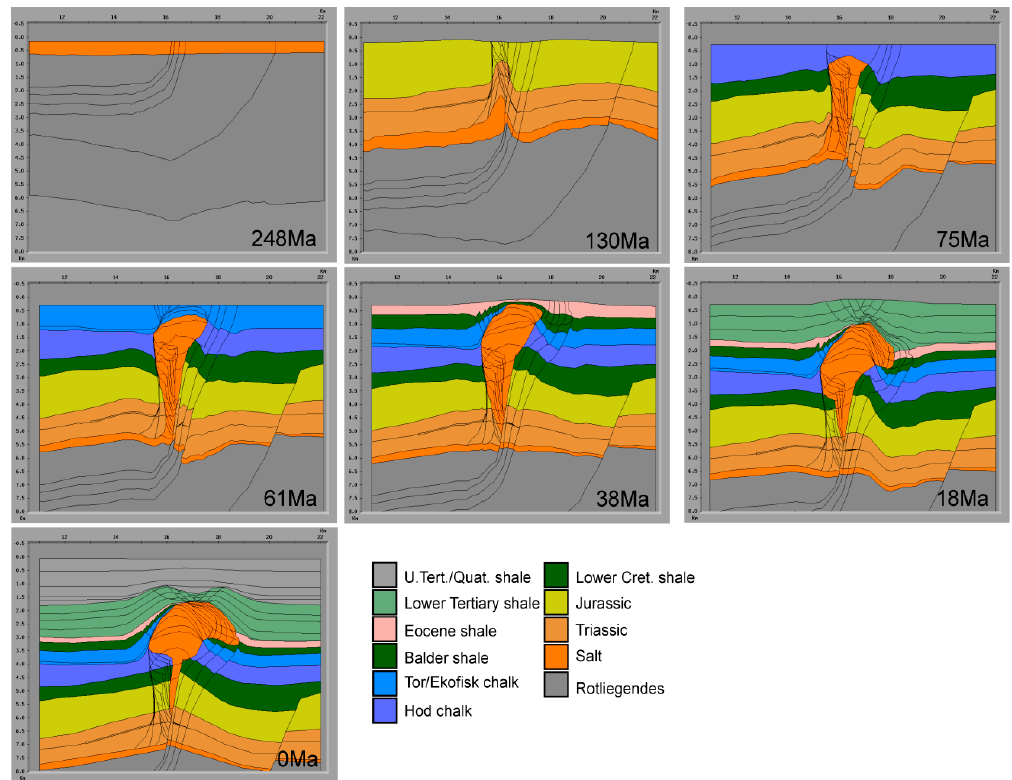
Figure 11. Reconstructed geohistory of Model 1, showing the stepwise evolution from a uniform salt layer to the present day salt balloon. The figure is colored based on the lithologies used in the model. The main salt volume protrudes through the Ekofisk and Hod chalks (in purple and blue) and is capped by Cenozoic shales.